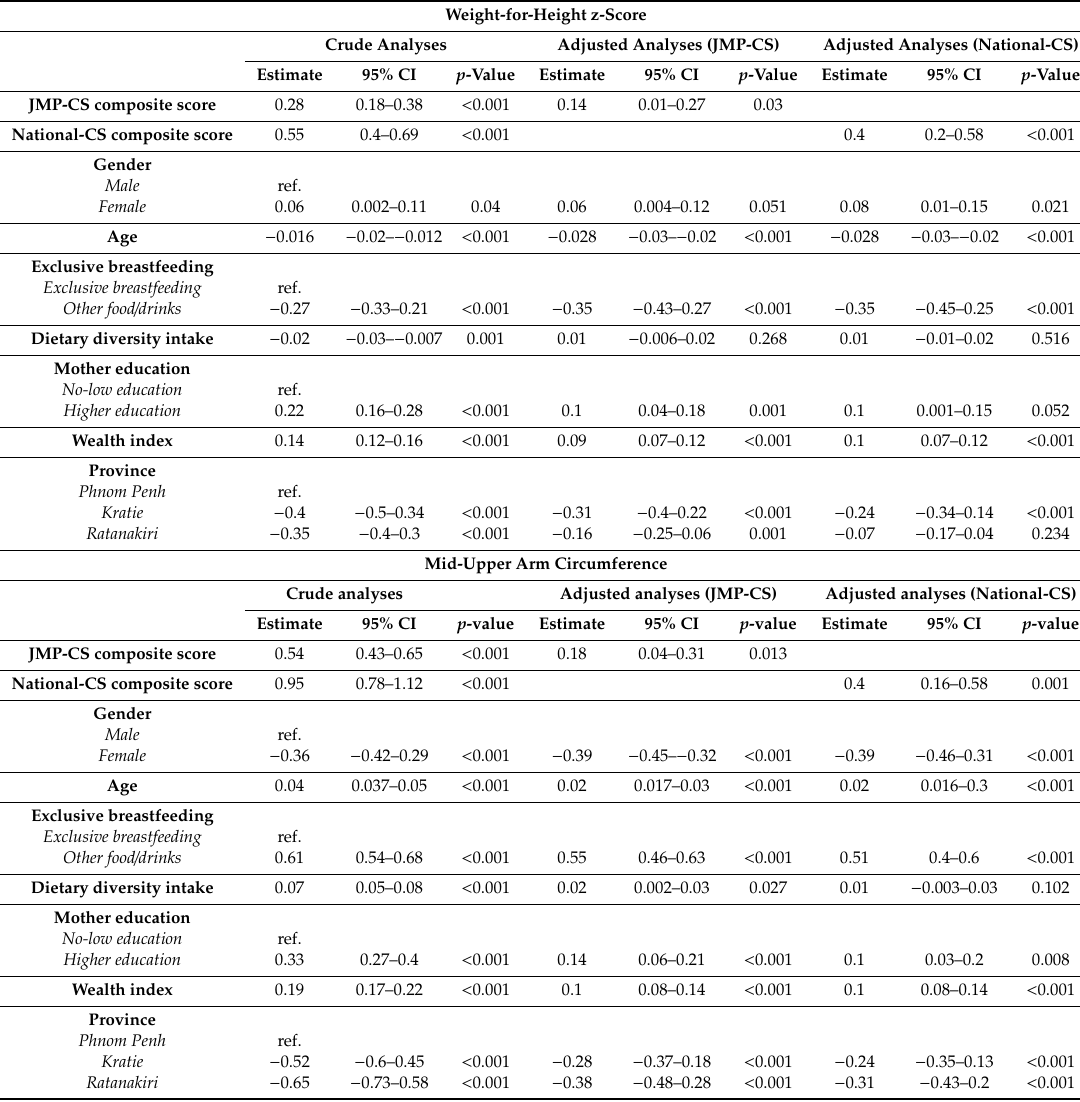
Table 2. JMP-CS and National-CS composite scores, gender, age, exclusive breastfeeding, dietary diversity intake, mother education, wealth index and province in relation to the weight-for-height z-scores and mid-upper arm circumference over